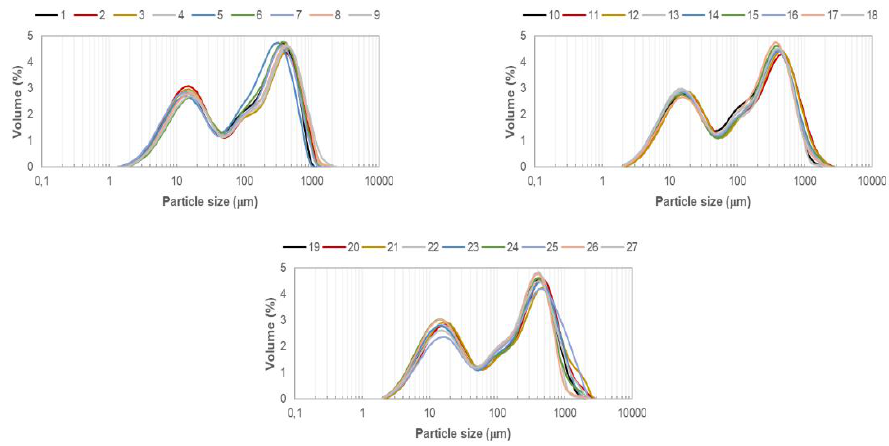
Figure 1. Volume particle size distribution (representative curves) of chuculas studied.